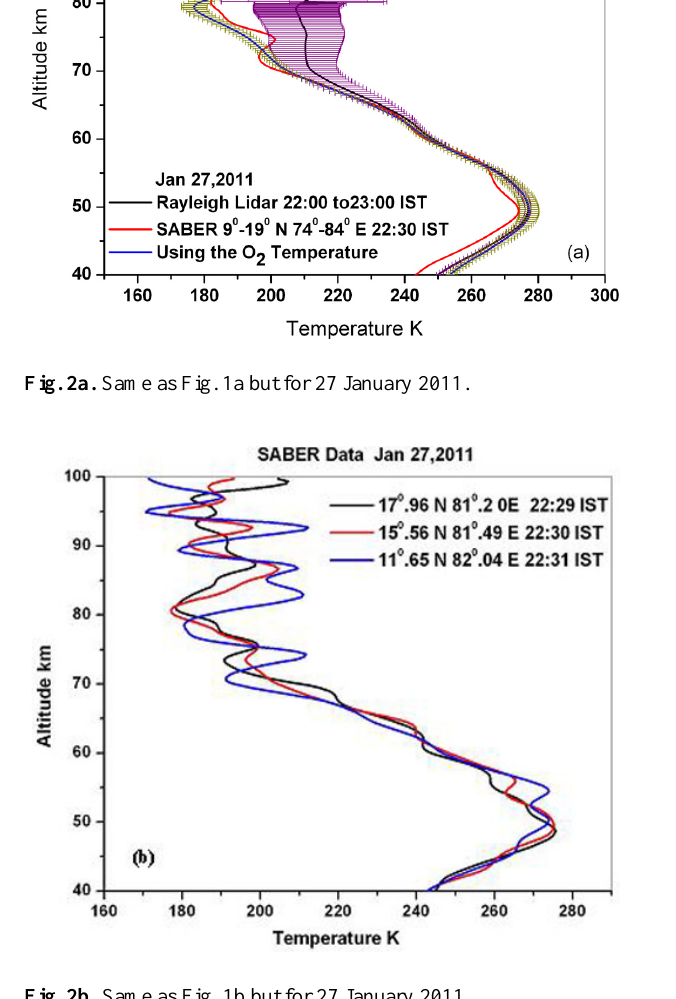
Fig. 2b. Same as Fig. 1b but for 27 January 2011.